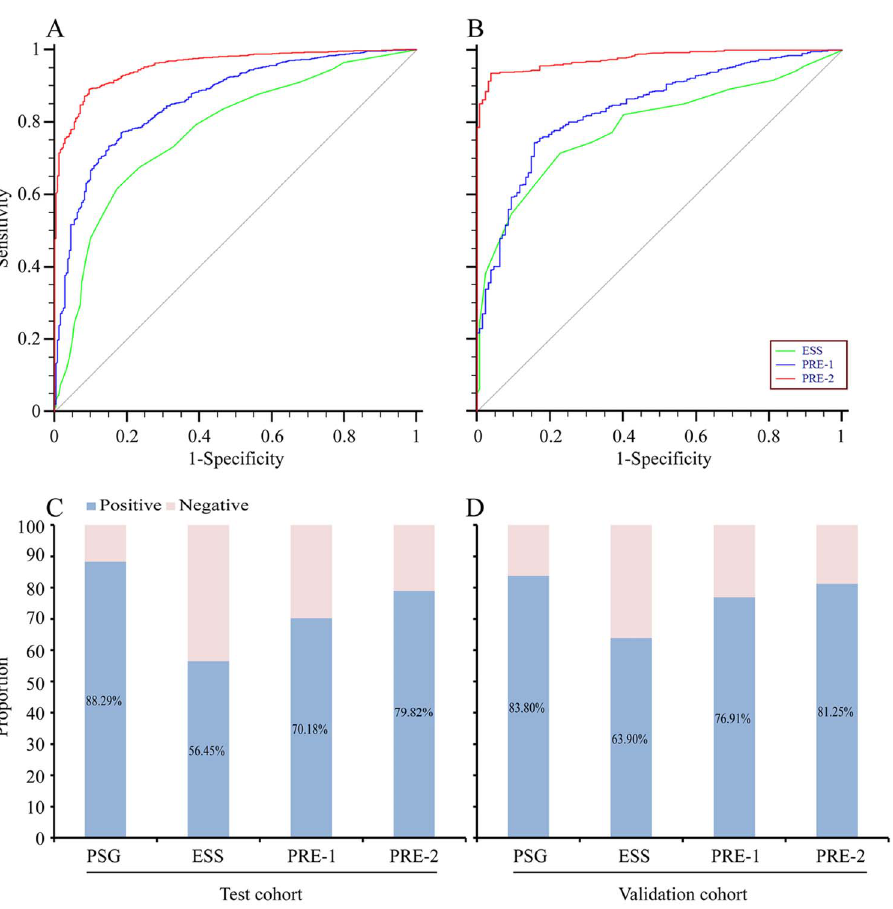
Figure 2. Diagnostic outcomes for Epworth Sleepiness Scale, PRE-1 and PRE-2 in screening OSA. (A) ROC curve for ESS, PRE-1 or PRE-2 versus PSG in the test cohort. (B) ROC curve for ESS, PRE-1 or PRE-2 versus PSG in the validation cohort. (C) Rate of positive results for PSG, ESS, PRE-1 or PRE-2 in the test cohort. (D) Rate of positive results for PSG, ESS, PRE-1 or PRE-2 in the validation cohort. OSA=obstructive sleep apnea; ESS=Epworth Sleepiness Scale; PRE-1=the predictive variable for the first diagnostic model; PRE-2=the predictive variable for the second diagnostic model; ROC curve=the receiver operating characteristics curve; PSG=polysomnography.